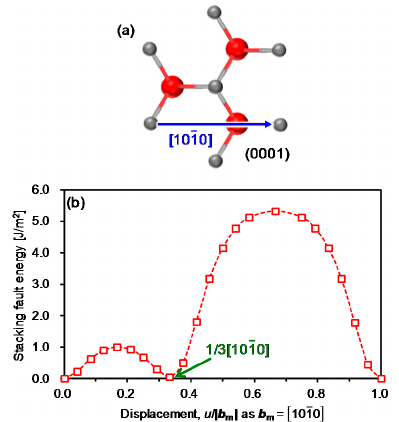
Figure 6. ( a ) Schematic illustration showing the [101 (cid:3364) 0] vector on (0001). ( b ) Stacking fault energies along [101 (cid:3364) 0] on (0001) in ZnO. It can be seen that the energy indicates the local minimum at the displacement of 1/3[101 (cid:3364) 0].